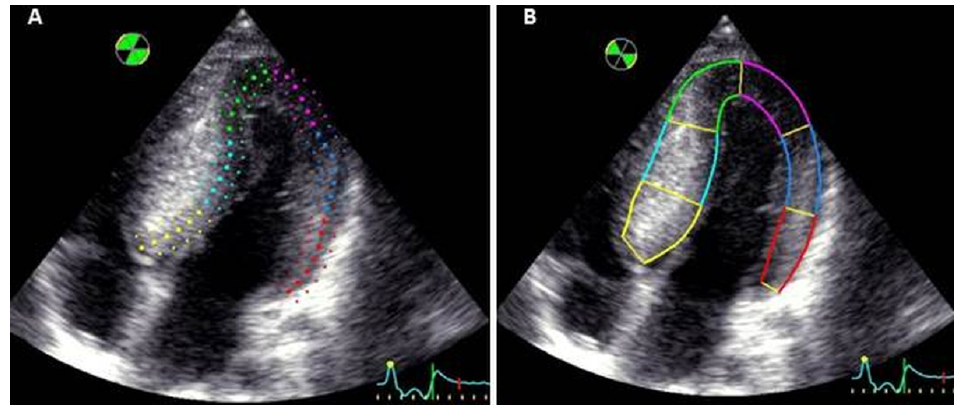
Figure 1. Myocardial contouring in the same apical four-chamber view ( A ): with standard software and ( B ): with software adjusted to the myocardial wall thickness.